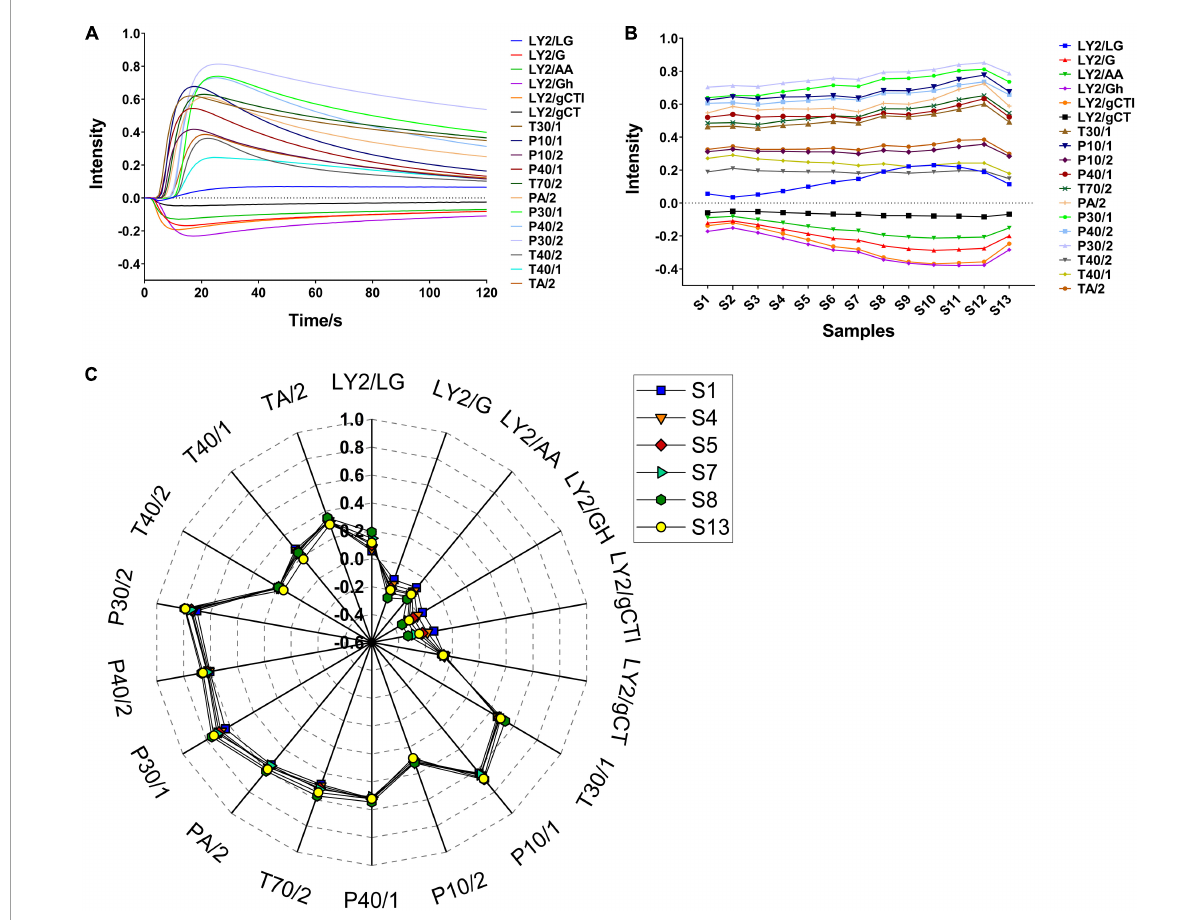
FIGURE1 Typical plots of E-nose in CF roasting process. (A) Sensor intensity curves in S1; (B) the change of the maximum response value of all samples; (C) radar fingerprint chart of maximum sensor response on typical samples.